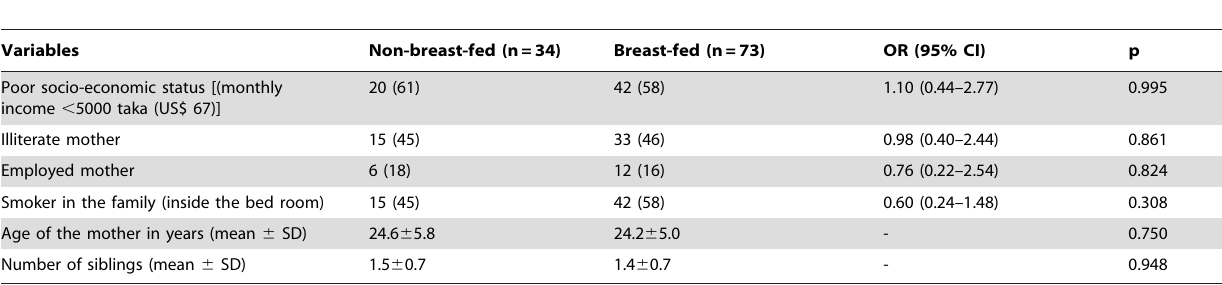
Table 3. Comparison of parental socioeconomic status and environment of breast-fed and non-breast-fed infants with pneumonia and diarrhea.